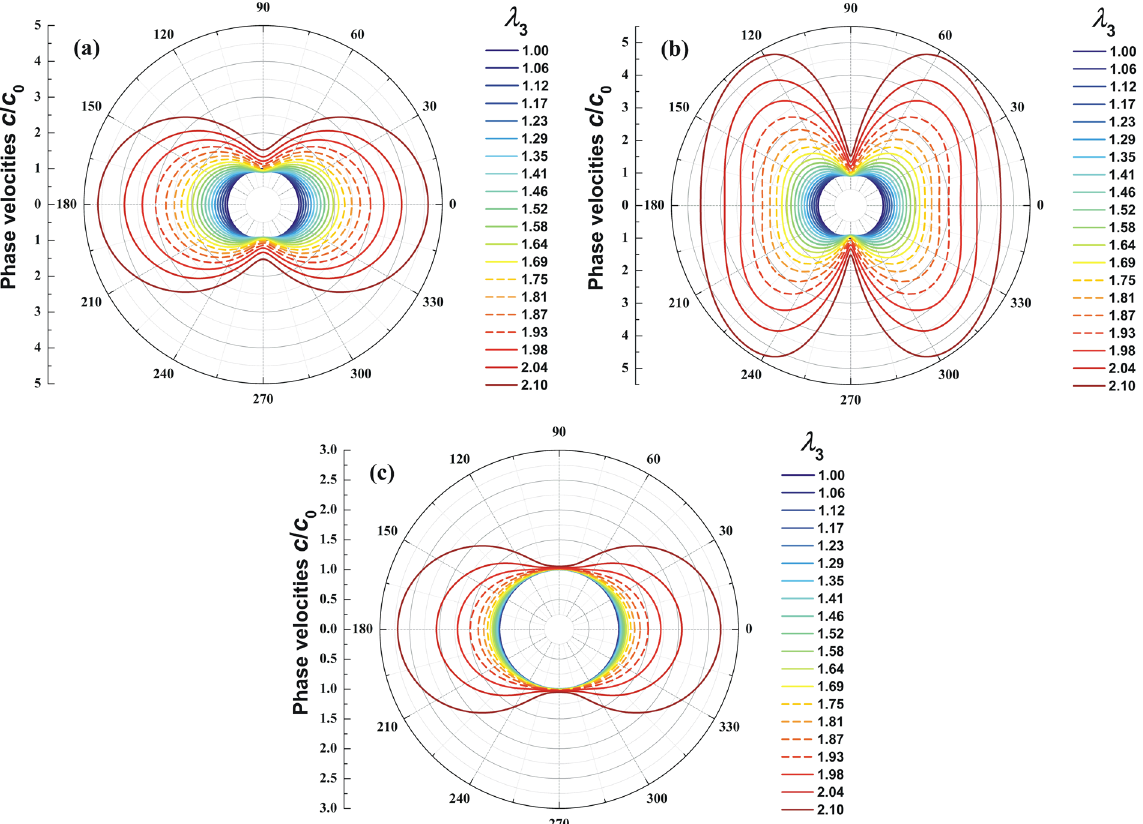
Figure 2. Phase velocity polar diagrams of self-controlled elastic waves in a compressible hyperelastic medium in the yz plane: ( a ) purely-transversal velocity; ( b ) quasi-transversal velocity; ( c ) quasi-longitudinal velocity. Solid lines correspond to stable regime while dashed lines denote unstable